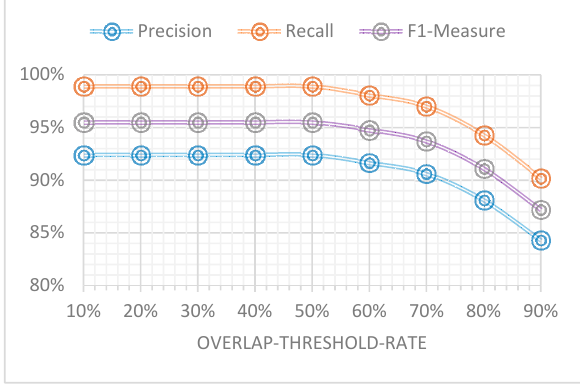
Figure 11. Relationship between footstep detection performance and overlap-threshold-rate.